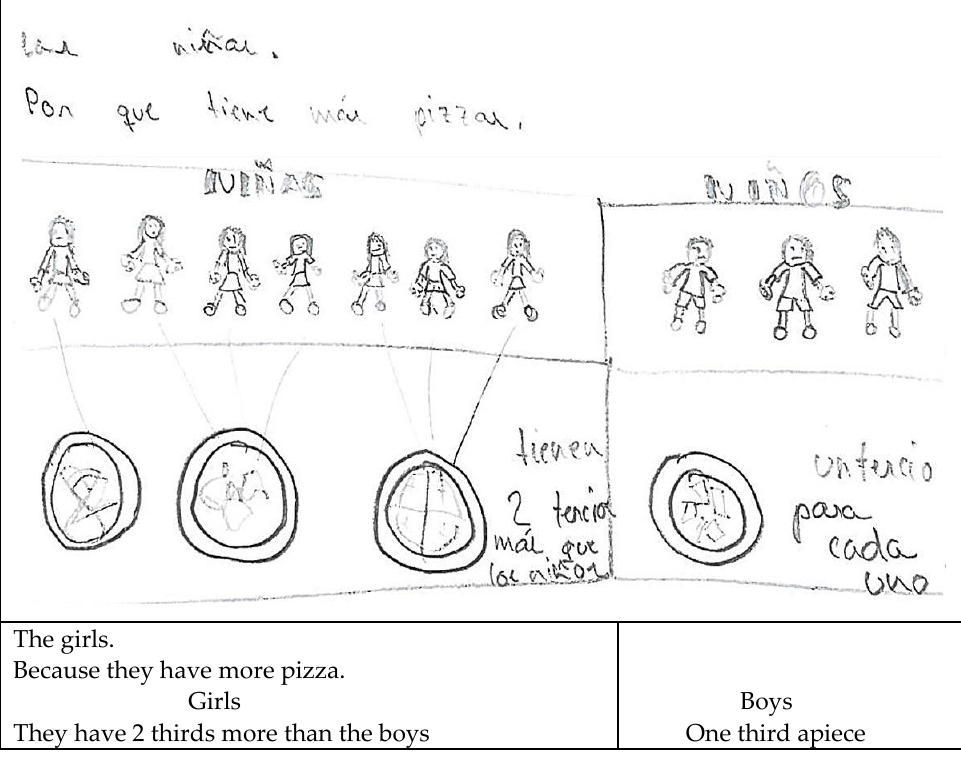
Figure 5. Example of the unitisation strategy.